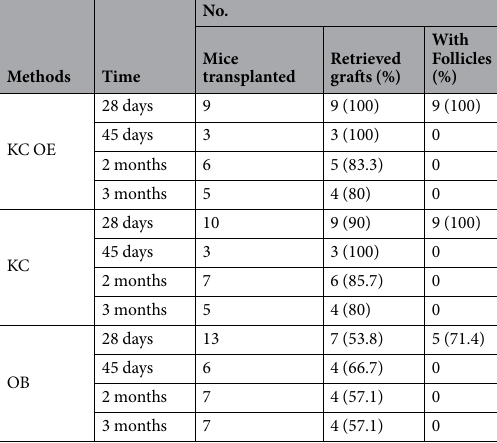
Table 1. Folliculogenesis of PGCs-aggregates transplanted into the recipient mice. One aggregate was transplanted into one recipient mouse by KC OE (Kidney capsule ovariectomized), KC (Kidney capsule) or OB (Ovarian bursa). Time, days or months as indicated following transplantation of the